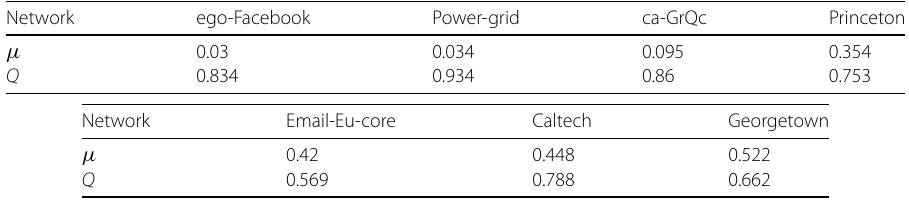
Table 4 The estimated mixing parameter μ and modularity Q of the real-world networks